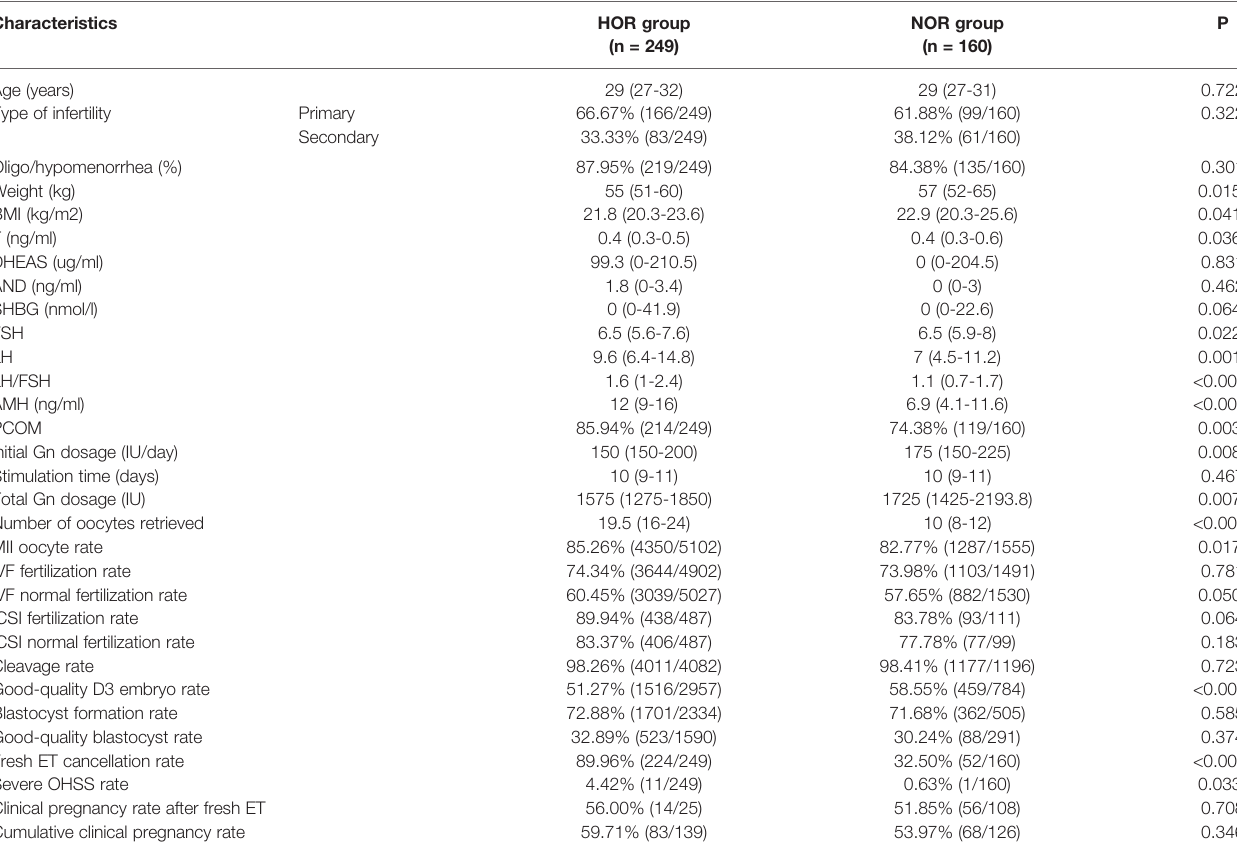
TABLE 3 | Comparison of characteristics in PCOS patients with high ovarian response and normal ovarian response (n = 409).